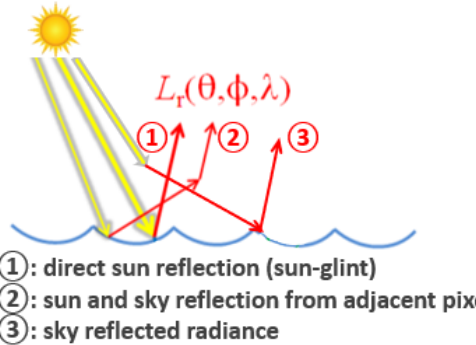
Figure 7 . Conceptual diagram of the surface-reflected radiance ( L r ). Mobley (2015) generated ρ at the sea surface as a function of viewing direction and azimuth angle of the sensor, solar zenith angle, and wind speed. Figure 8 shows the ρ modelling result as a function of sensor viewing angle from nadir and sensor azimuth angle from the sun in the case of a fixed solar zenith angle (θ 0 ) of 40° and wind speed of 10 m s −1 . Because the sensor viewing angles for pixels were distributed between −18.85° and 18.89°, ρ values within the red dotted line in Figure 8 were used for L r correction. According to the relative azimuth angle from the sun to the sensor ( φ v ) for each scan line, the ρ values were extracted from Figure 8 and listed in Table 2. L r was calculated using the extracted ρ values (Table 2) and in situ L sky data. Both L r and L a were subtracted from L u to obtain L w . Finally, remote sensing reflectance ( R rs ) was calculated by dividing L w into in situ downwelling radiance.